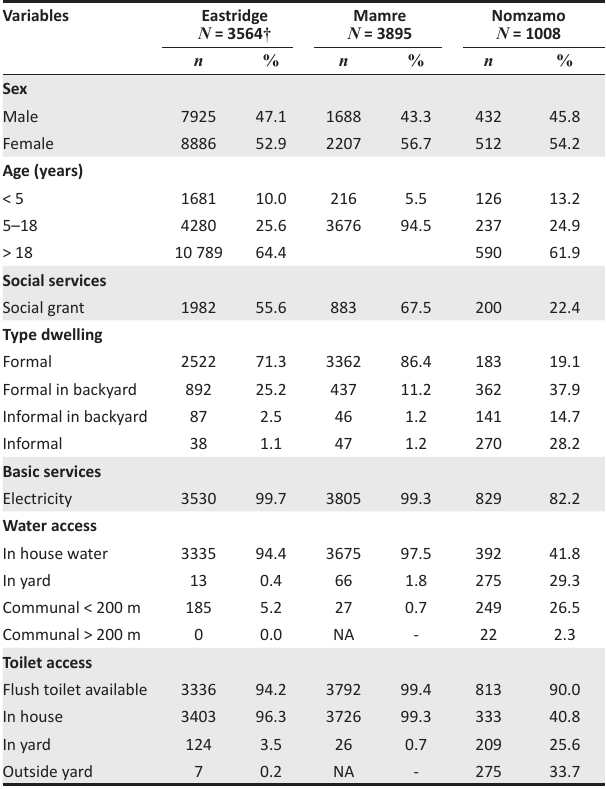
TABLE 1a: Demographics of population and characteristics of households. Variables